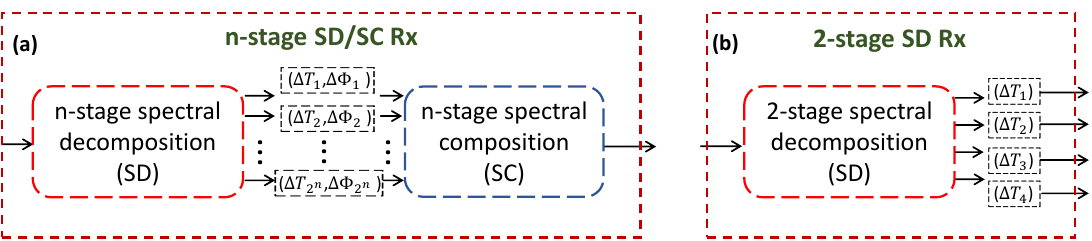
Figure 4. Optical pre-processing. ( a ) Complete optical module, ( b ) reduced optical module. Time delay and phase shift were trained to find the optimal point to mitigate CD.